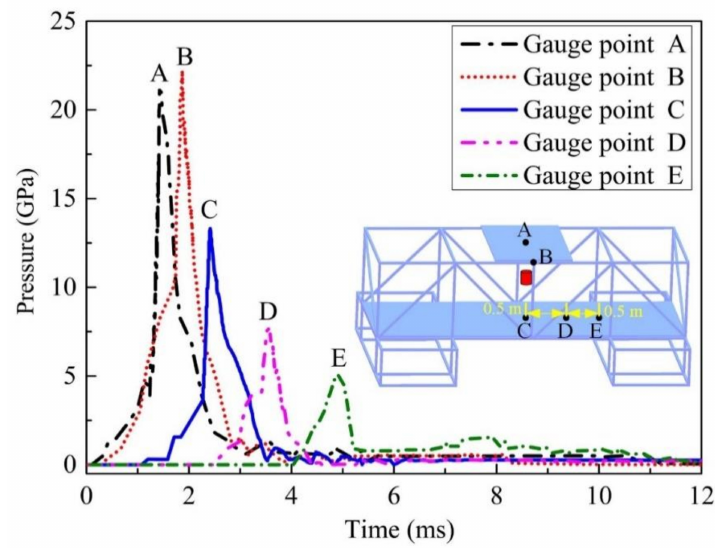
Figure 14. Pressure vs. time curves of some gauge points in